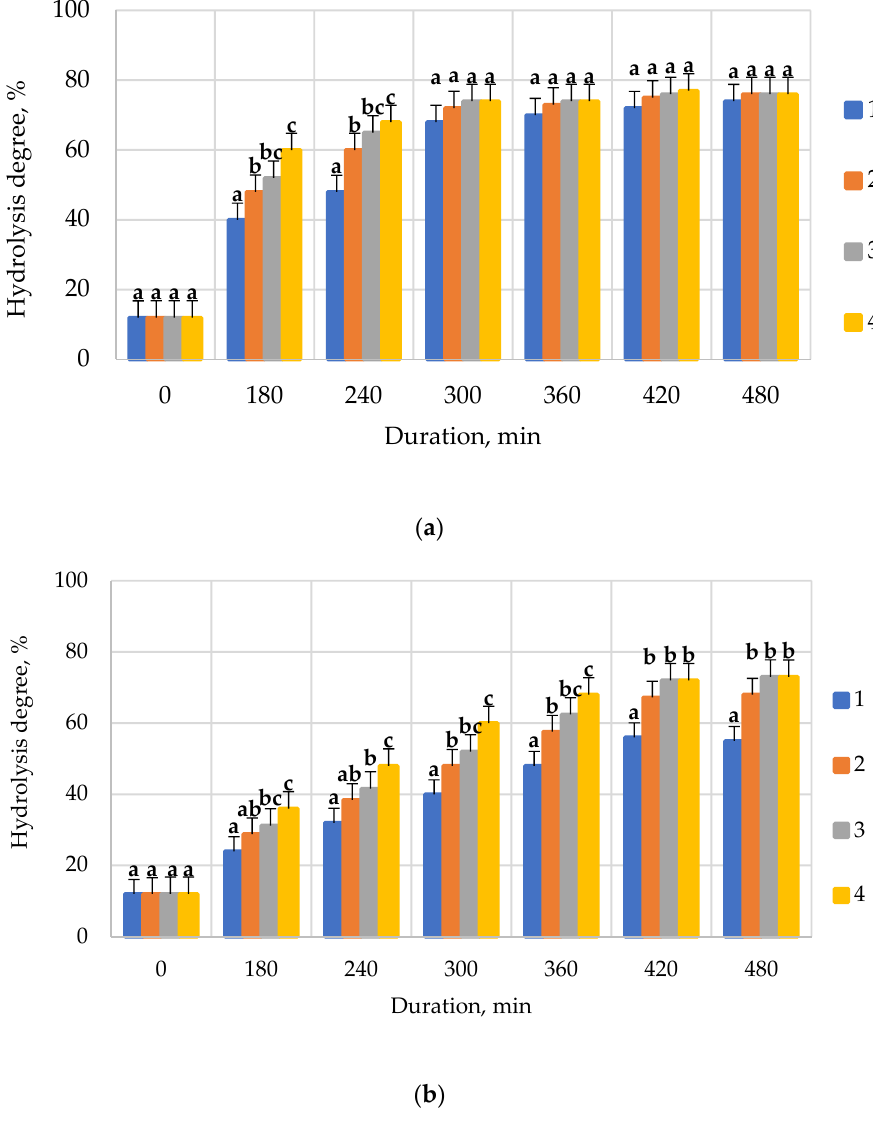
Figure 1. Study of the biodegradation of protein molecules in samples of collagen-containing raw materials by ( a ) collagenase or ( b ) Neutrase 1.5 MG at various concentrations of the enzyme, U/g: 1–150, 2–200, 3–250, 4–300. Values followed by the same letter do not differ significantly ( p > 0.05) as assessed by post hoc test (Tukey test).